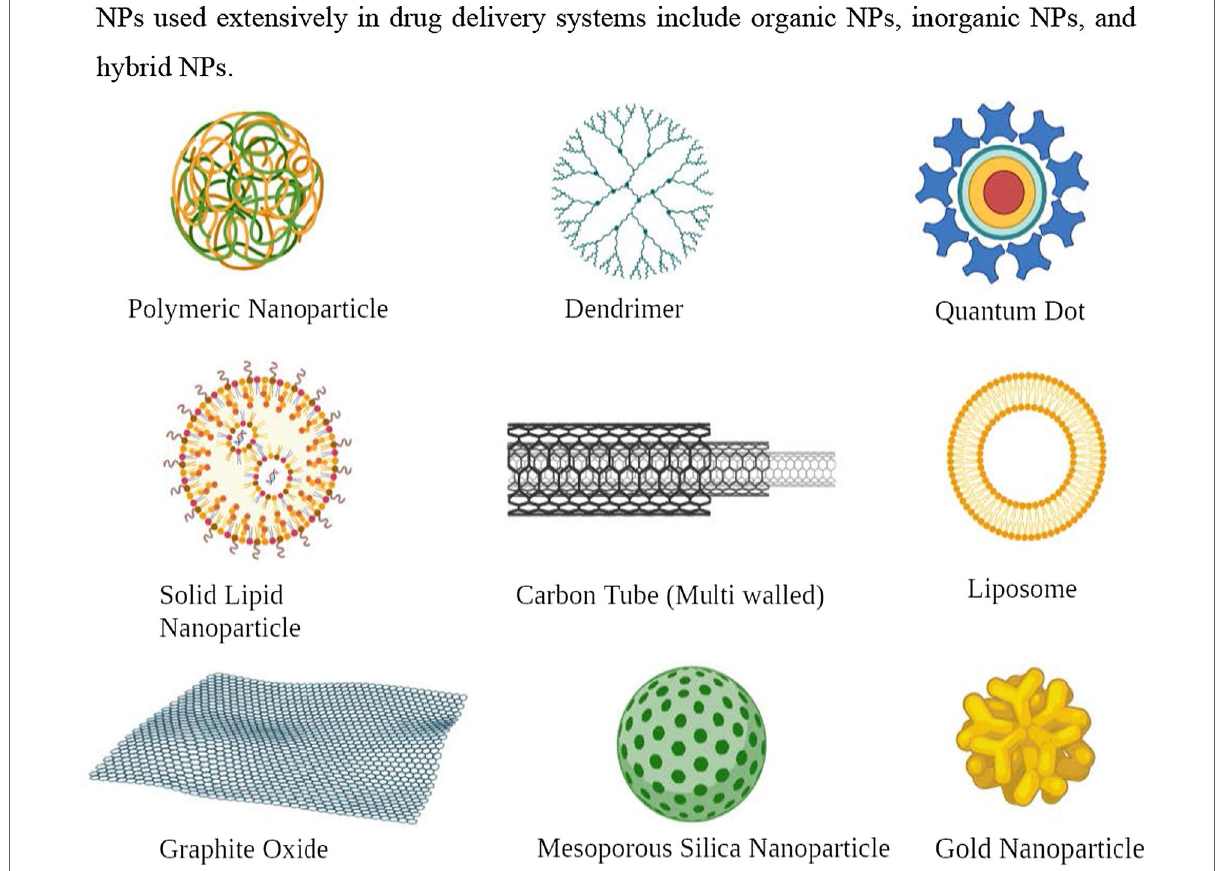
Fig. 5 Various types of nanomaterials used in cancer